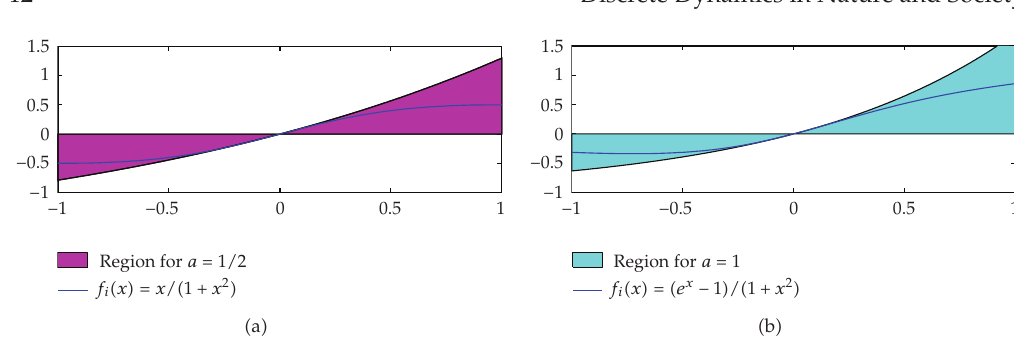
Figure 2: Plots of some admissible regions for f i according to Theorem